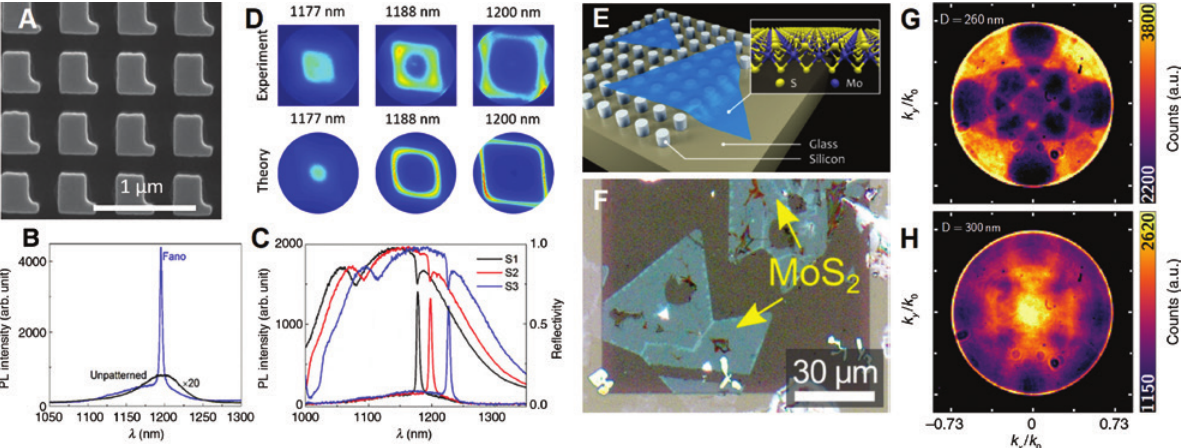
Figure 18: All-dielectric metasurfaces for spectral and spatial shaping of emission. (A) Scanning electron micrograph of an asymmetric GaAs metasurface containing InAs quantum dots and supporting a high-quality-factor Fano resonance. (B) Measured photoluminescence (PL) from the metasurface as compared to that from the unpattered wafer, showing strong emission enhancement at the wavelength of the Fano resonance. (C) Measured reflectance and PL spectra for asymmetric GaAs metasurfaces featuring a variation of their geometrical parameters, which allows spectral tuning of the wavelength of the emission peak. (D) Measured (top row) and numerically calculated (bottom row) back focal plane images of the metasurface emission for three different emission wavelengths. Figures (A–D) Reprinted with permission from [159]. Copyright (2018) American Chemical Society. (E) Sketch of a . (F) True-color light microscope image of a corresponding silicon nanocylinder metasurface decorated with monolayer crystals of MoS 2 fabricated sample. (G, H) Experimentally measured back-focal plane image of the monolayer MoS emission for a nanocylinder diameter of 2 (G) 260 nm and (H) 300 nm. Figures (E–H) Reprinted with permission from [145]. Copyright (2019) American Chemical